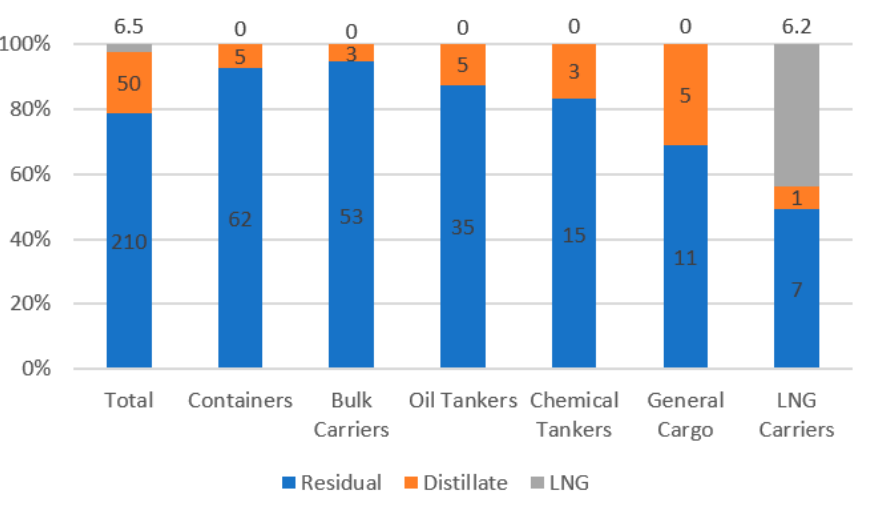
Figure 2. Classification by type of marine fuel according to the shipping sector, adapted from Comer et al. Comer et al. [32].